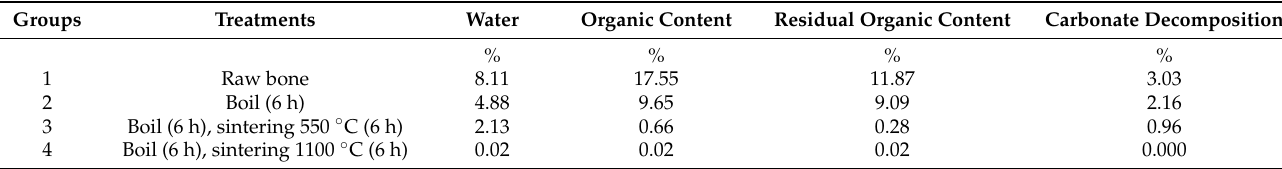
Figure 1. Overlay graph of TGA curves of the different groups of bovine bone blocks showing percentage weight loss with increase in temperature. Up to 200 ◦ C = loss of evaporated and bound water, 200–375 ◦ C = loss of organic tissue, 375–550 ◦ C = loss of residual organic tissue and 550–775 ◦ C = carbonate decomposition. Table 1. Thermogravimetric analysis of bone samples.